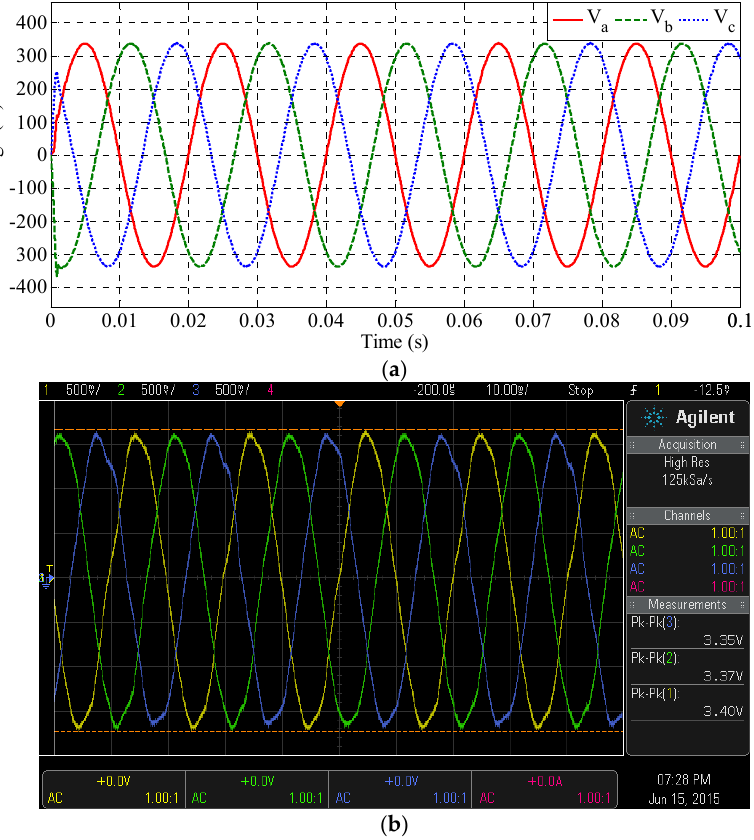
Figure 22. Output voltage waveforms ( i.e. , V a , V b , and V c ) of the three-phase inverter with RL load for ( a ) simulation and ( b ) experimental.